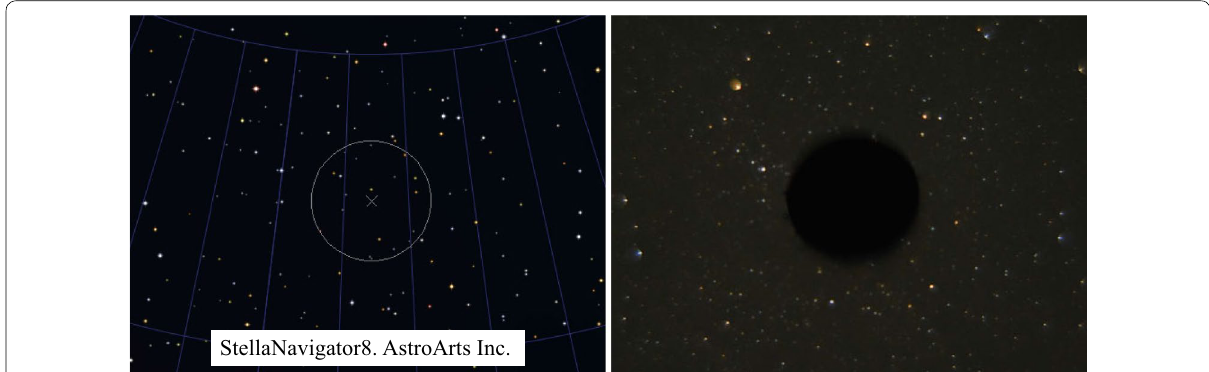
StellaNavigator8. AstroArts Inc. Fig. 3 A star chart (left) and a sky image (right) obtained by digital camera with an exposure time of 10 s at 19:51:20 UT on September 28, 2017. The cross on the left chart denotes the position of the local field-aligned position (Azimuth the left is 2 degrees, and the field of view of the star images are about 8°